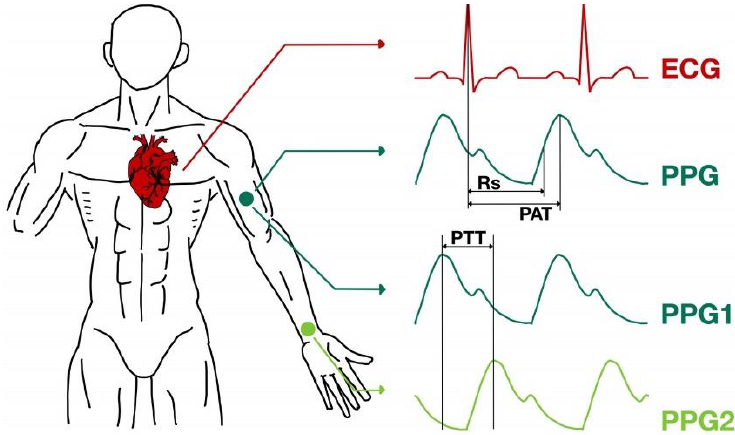
Figure 1. Pulse arrival time (PAT) and pulse transit time (PTT).